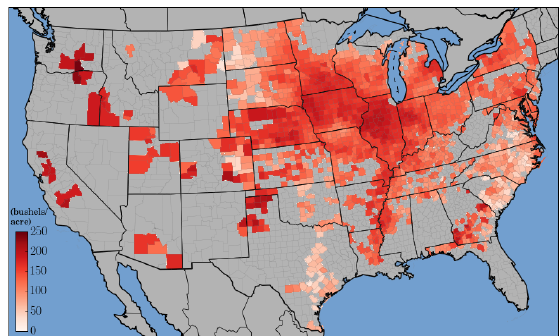
Figure 2: Corn yield of counties in 2008